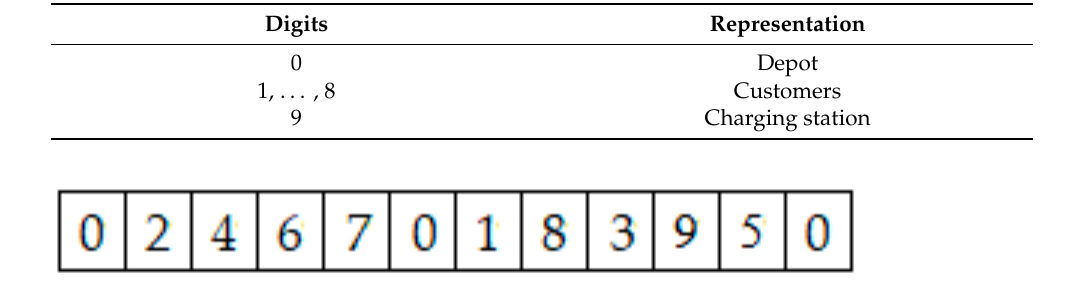
Table 1. Chromosome digital representation.